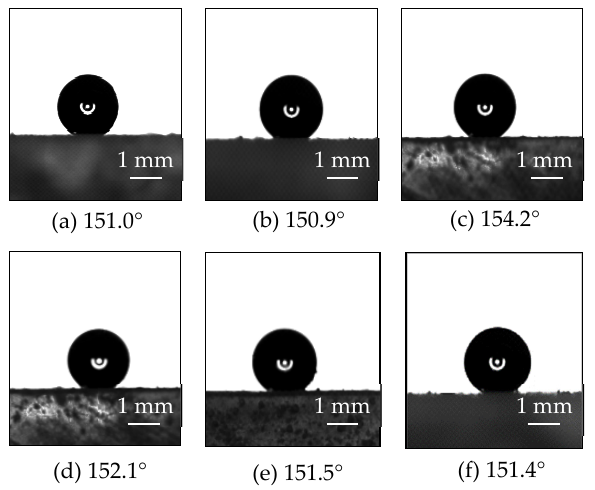
Figure 2. Contact angles of water droplets at different positions on superhydrophobic surfaces.